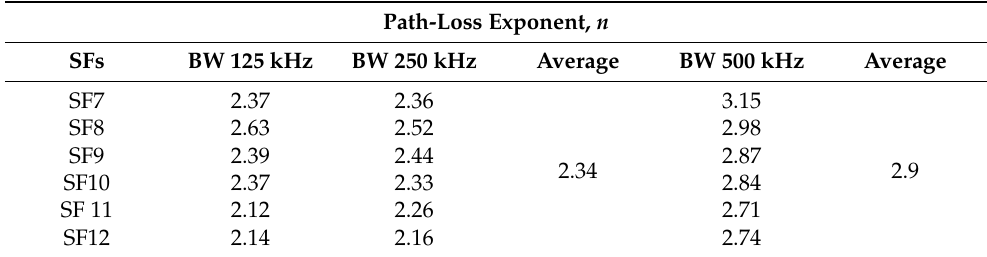
Table 4. Path-loss exponent ( n ) prediction value.